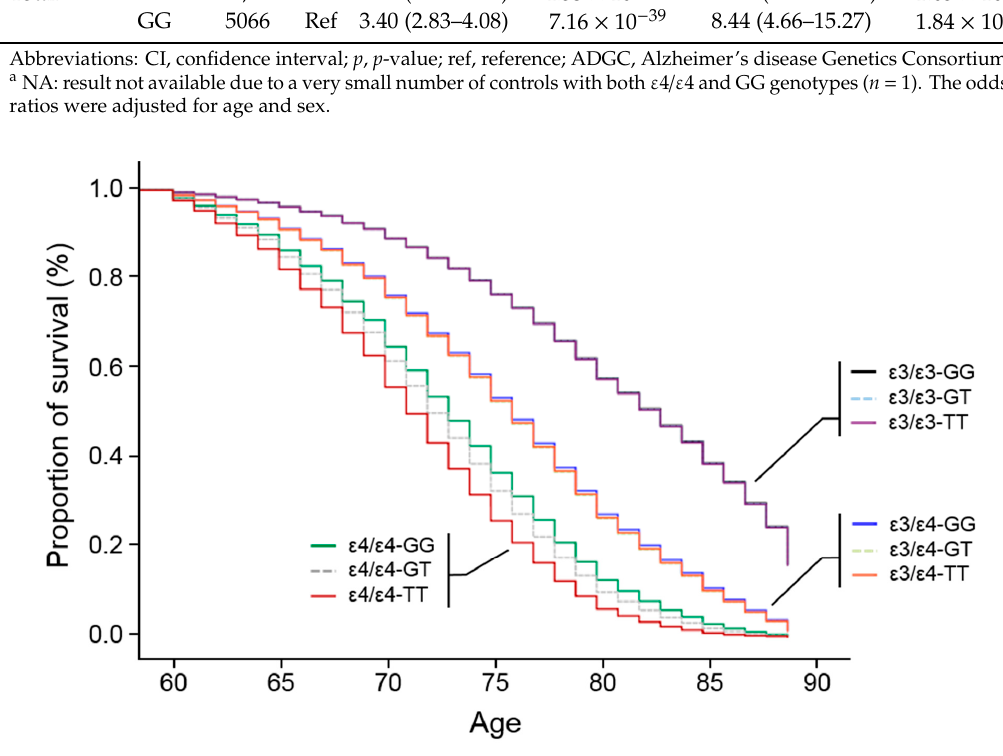
Table 2. Modifying effect of rs405509 on association of APOE (apolipoprotein E) genotype and Alzheimer’s disease.